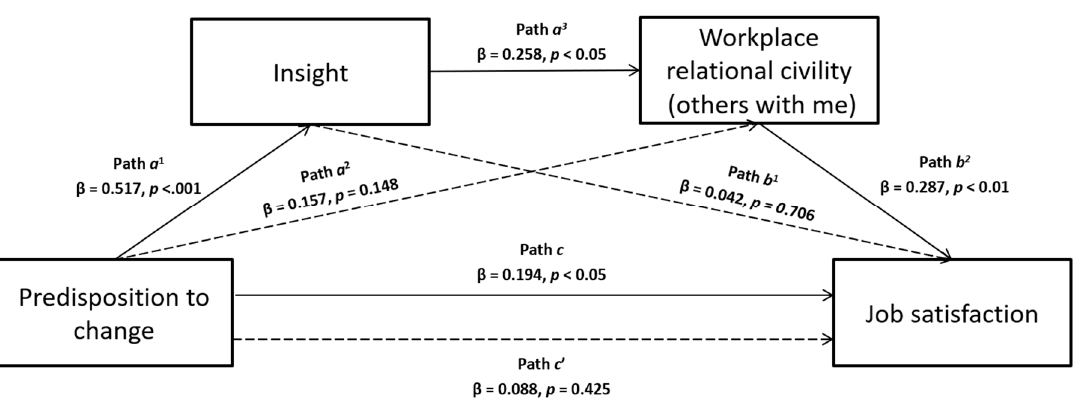
Figure 3. A serial multiple mediation model with predisposition to change as an independent variable, job satisfaction as the outcome, and both insight and workplace relational civility (others with me) as mediators, supported by analyzes